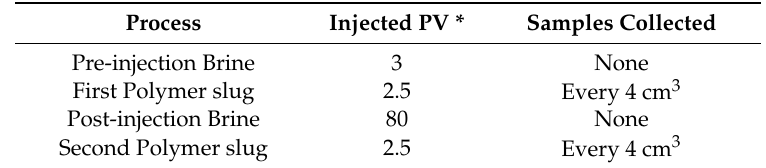
Table 3. Summary of a higher molecular weight polymer (AN 113 VHM) and hydrodynamic retention for lower molecular weight (AN 113 VLM) polymer-enhanced